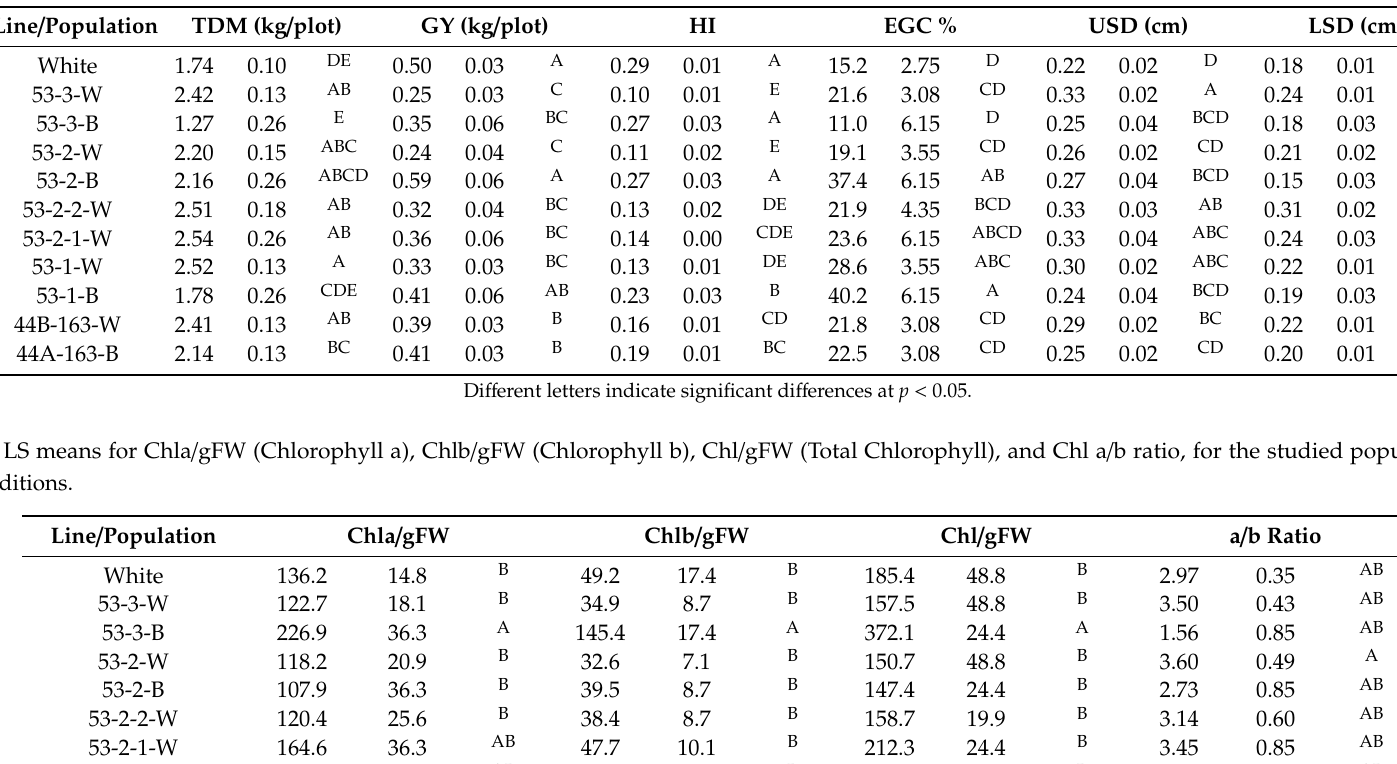
Table 3. LS means for TDM (Total Dry Matter, g / plot), GY (Grain Yield, g / plot), HI (Harvest Index), EGC (Early Ground Cover), LSD (Lower Stem width), USD (Upper stem width) for the studied populations and the commercial cultivar ’white’ under field conditions.